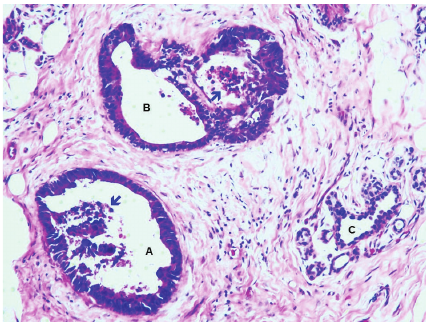
Figure 5: Neoplastic colonic glands (A and B) show hyperchro- matic, crowded nuclei, loss of nuclear polarity, and pseudostratifi- cation, intermixed with normal breast ducts (C). Necrosis is noted in neoplastic colonic glands (arrow) (Hematoxylin and Eosin stain, 200x magnification).